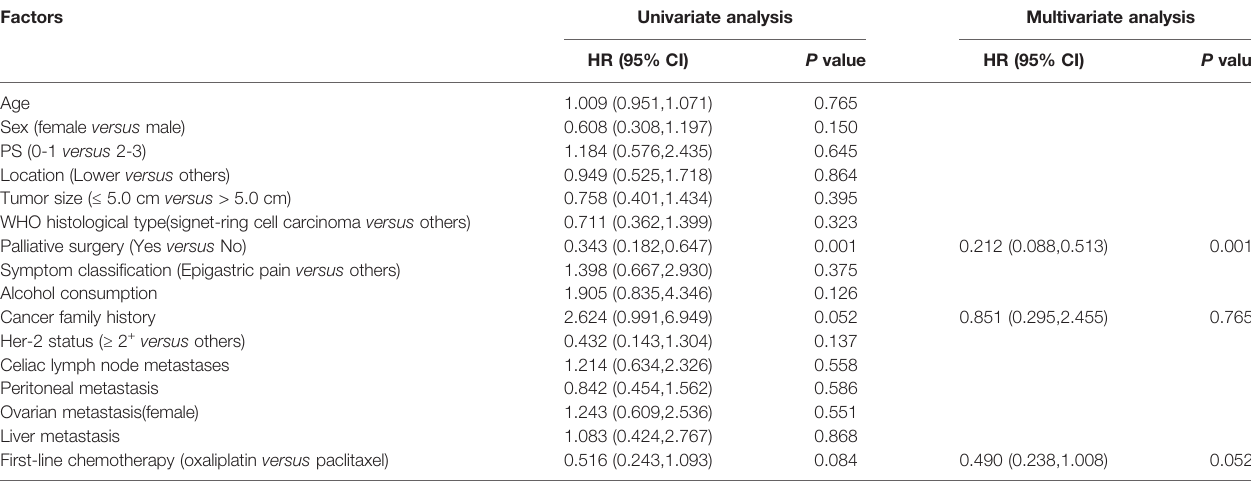
TABLE 4 | Univariate and multivariate analyses for overall survival associated with unresectability of EOGC patients. Factors Univariate analysis Multivariate analysis